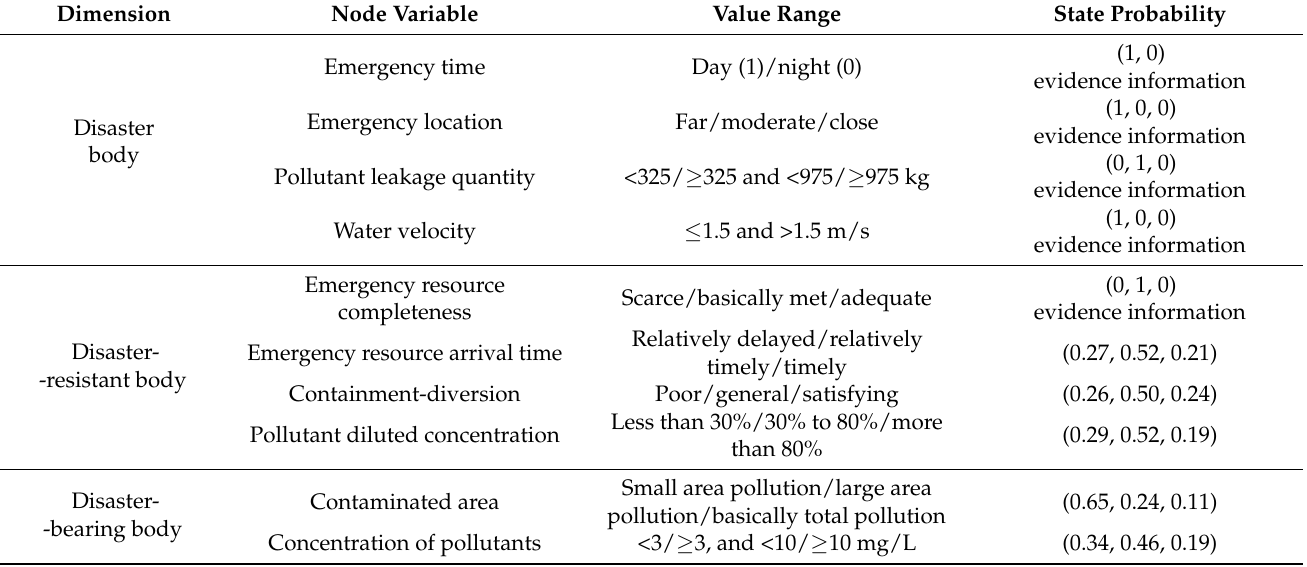
Table 8. State probability of each node variable in WEE